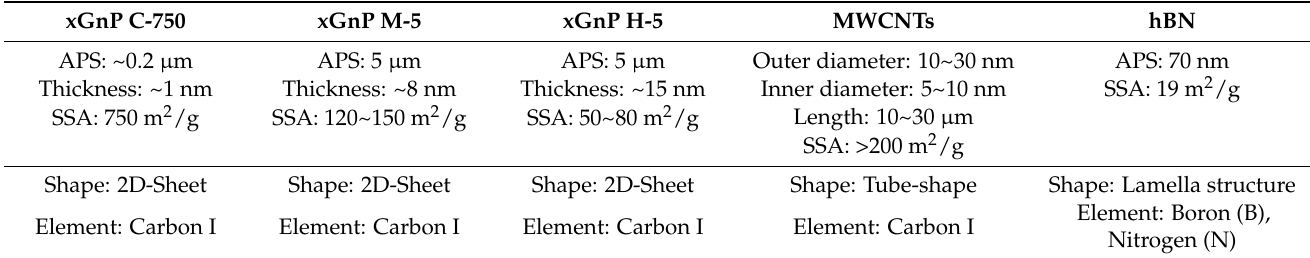
Table 1. Properties and shapes of xGnPs, MWCNTs, and hBN [19 – 21].